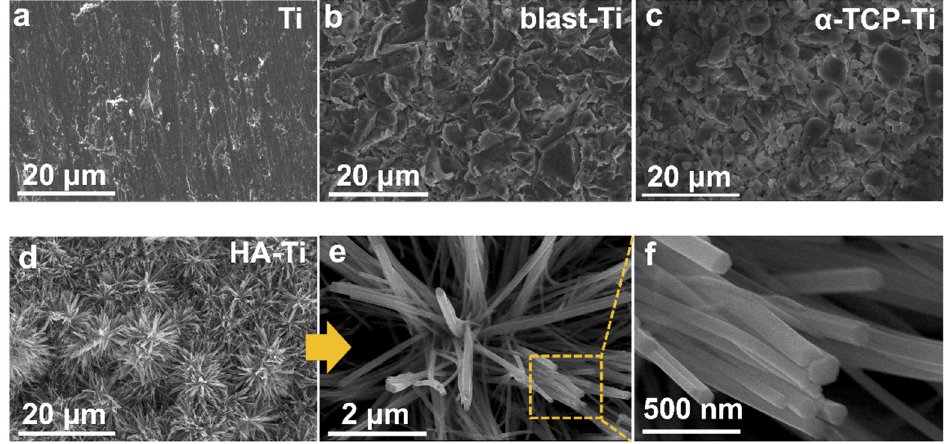
Figure 3. Scanning electron micrographs of ( a ) Ti, ( b ) blast-Ti, ( c ) α -TCP-Ti, and ( d–f ) HA-Ti discs. ( f ) Magnification of the area marked by the yellow rectangle in ( e ).